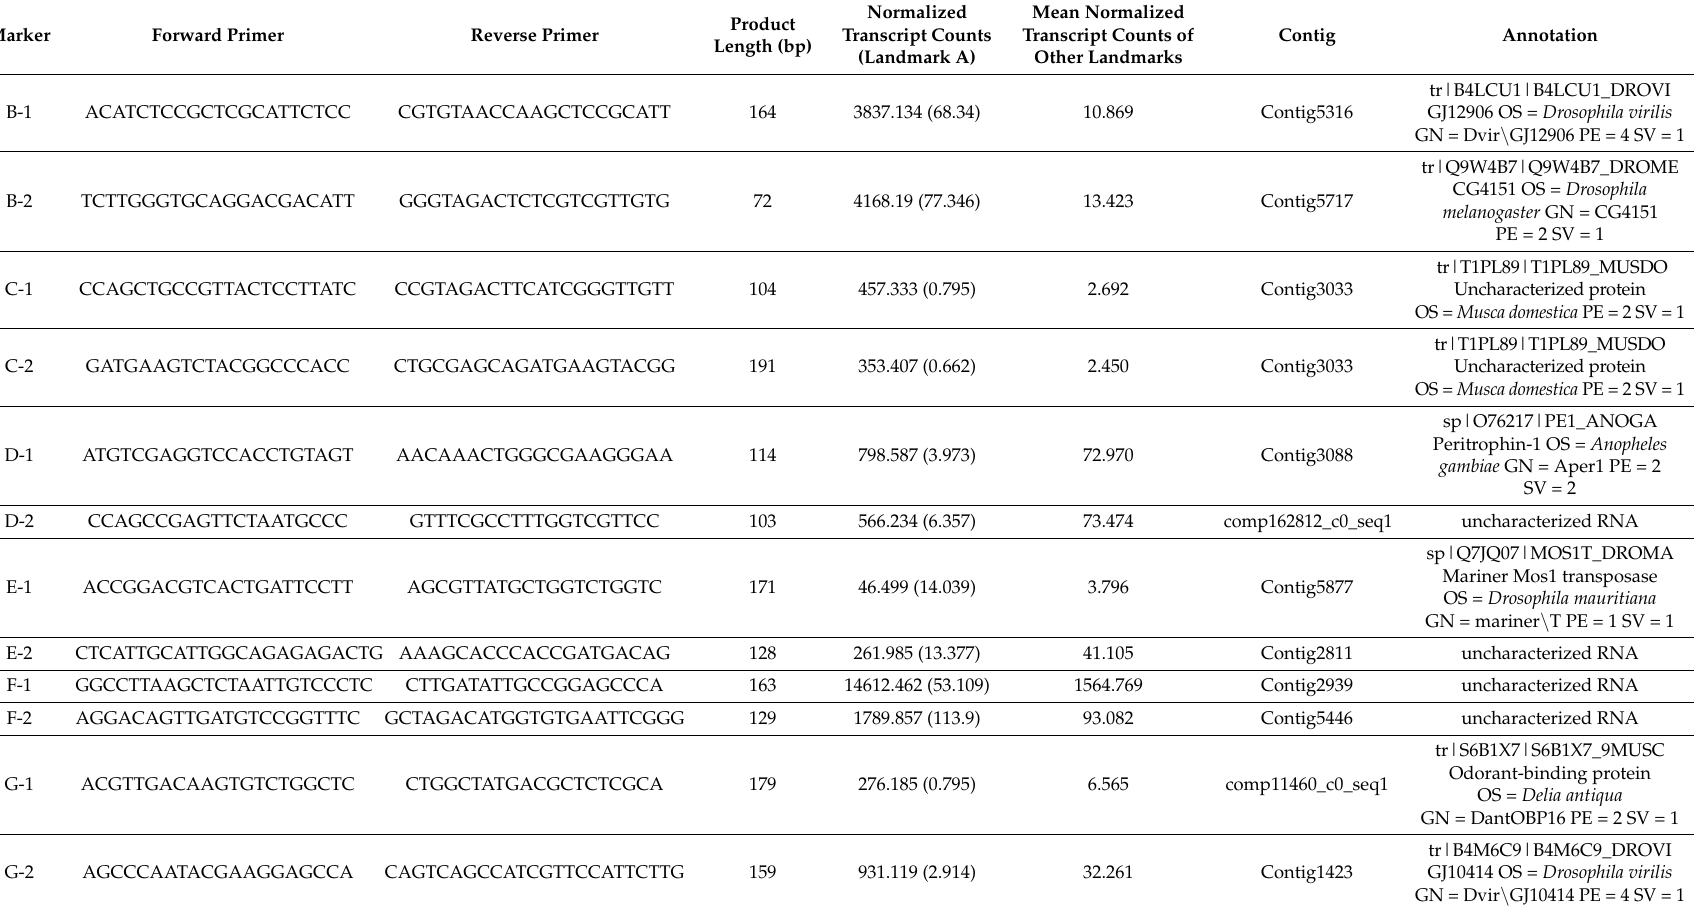
Table 3. Markers and primer sequences used for analysis of C. vicina pupae in this study. Contig aliases and annotations are given for reference. Annotated via basic local alignment search tool (BLAST) assembly mapping against Drosophila and general insect data sets available in GenBank (BLASTX) and UNIPROT database [28]. Massive analysis of complementary DNA ends (MACE) count numbers of the used transcripts are indicated against landmark A (white prepupa) and in comparison to the mean count numbers at all other developmental